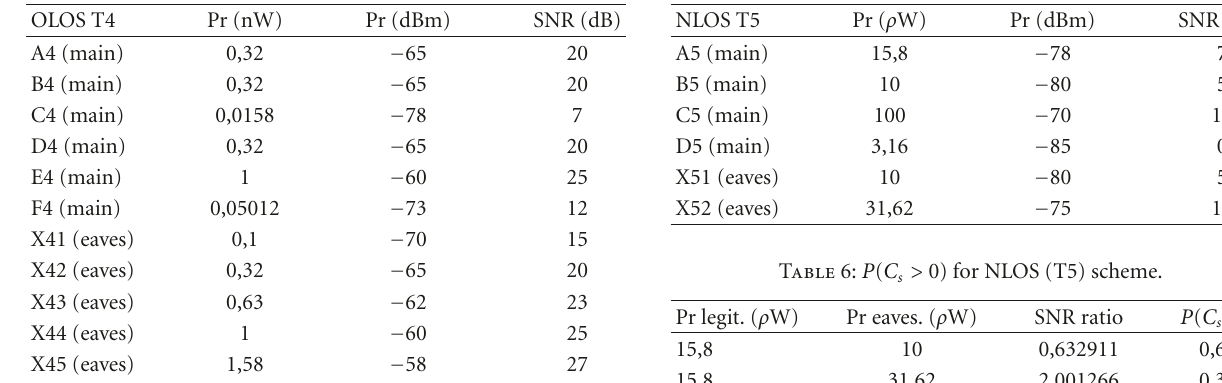
Table 3: Average received power and SNR for OLOS-2 (T4) scheme.